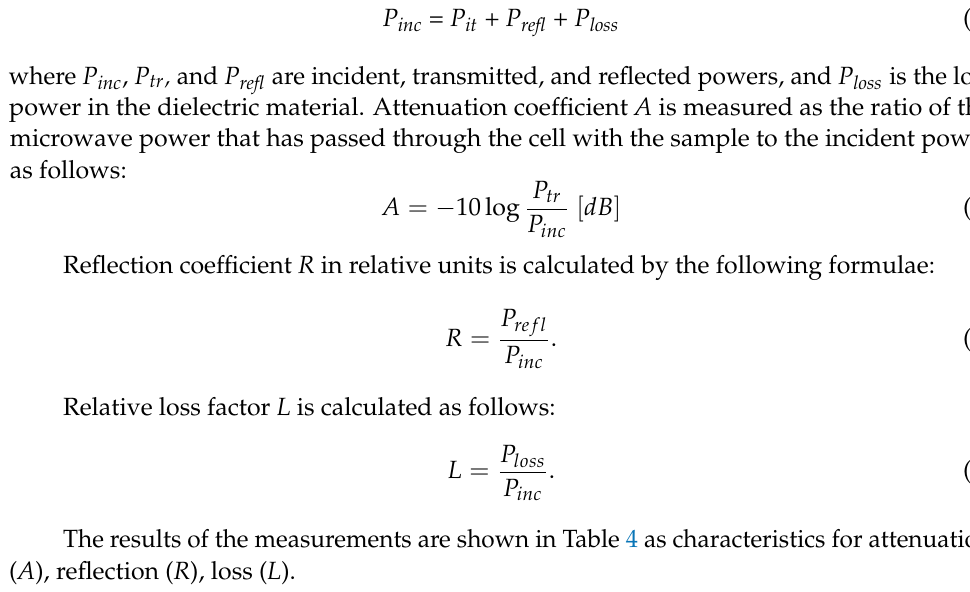
Table 4. Attenuation, reflection, and loss coefficients of the palladium nanoparticles samples.